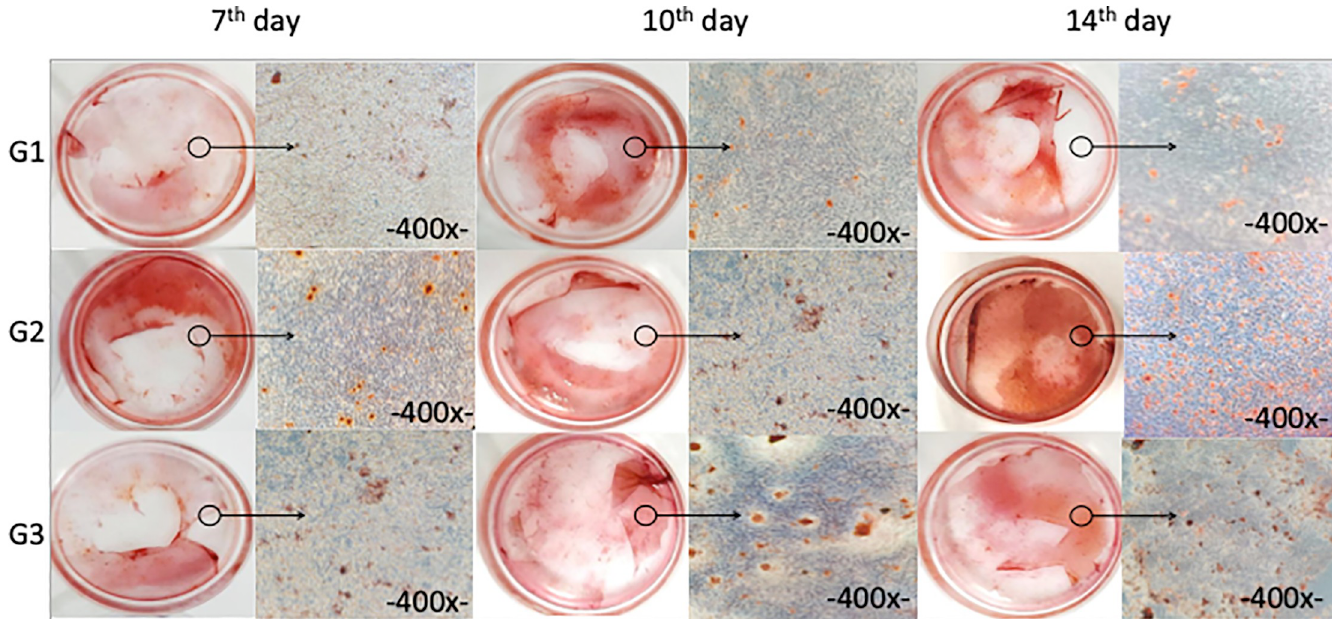
Fig 8. Macroscopic and microscopic analysis of mineral nodules by Alizarin Red in groups G1, G2, and G4 after 7, 10, and 14 days of cell culture.